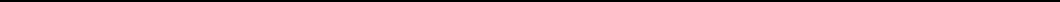
Table 2 Spearman ’ s rank correlation coef fi cients ( r ) and associated P values of age (control persons + patients), MELD score (patients), and HSA variables (control persons + patients) with ranked distances determined from P ( r ) function at intensity P ( r ) = 0.2 (see Fig. 2a), maximal dimension derived from P ( r ) function ( D max ) (see (Supplementary Table 2) and area under the Kratky plot (see Fig. 1d and Supplementary Table